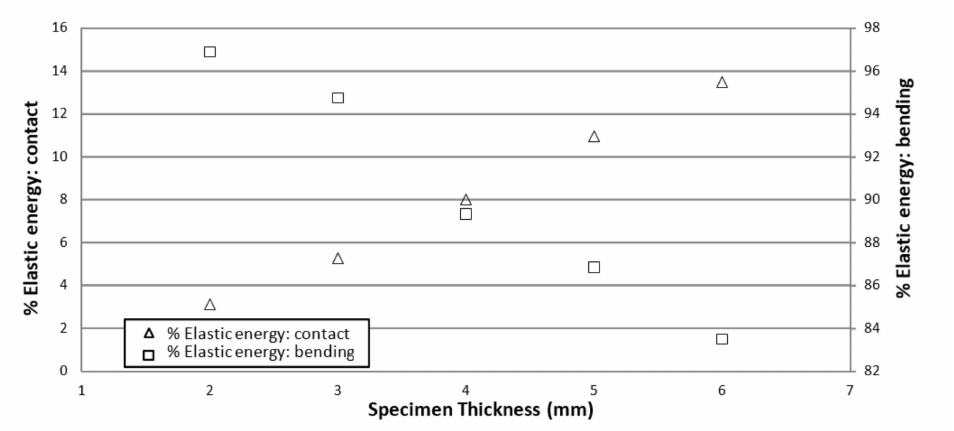
Figure 12. Percentage of elastic recovered energy due to contact and bending as a function of the specimen